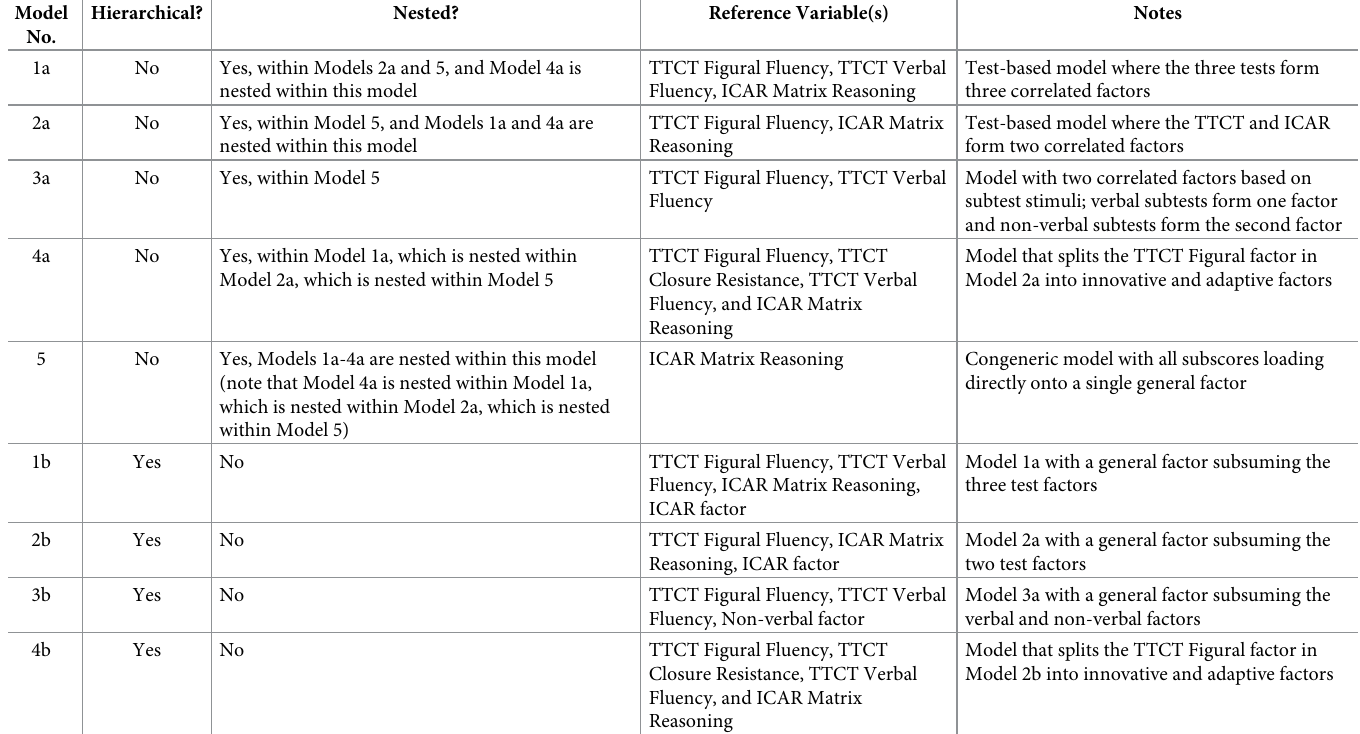
Table 1. Proposed models for interrelationships among TTCT and ICAR subscores. Model